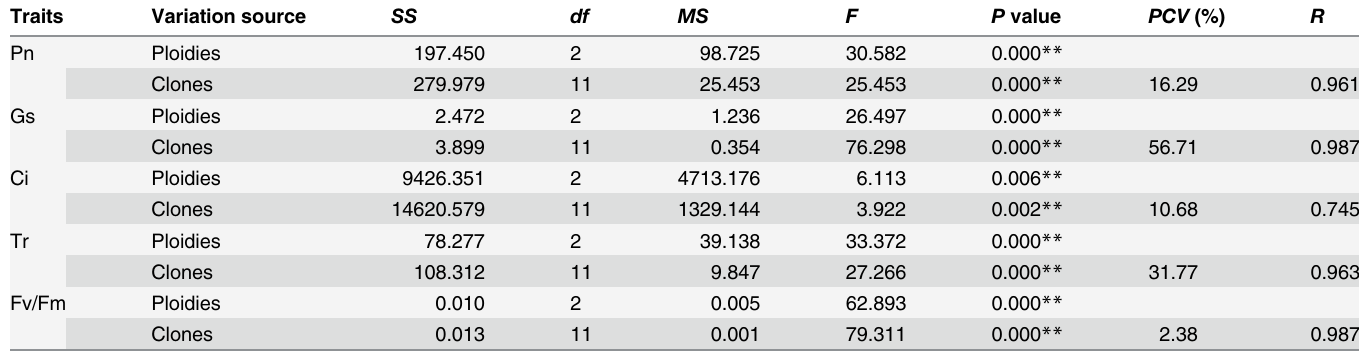
Table 5. ANOVA analyses for PCV and R of clones of different ploidies and clones in photosynthetic and chlorophyll fluorescence traits. Traits Variation source